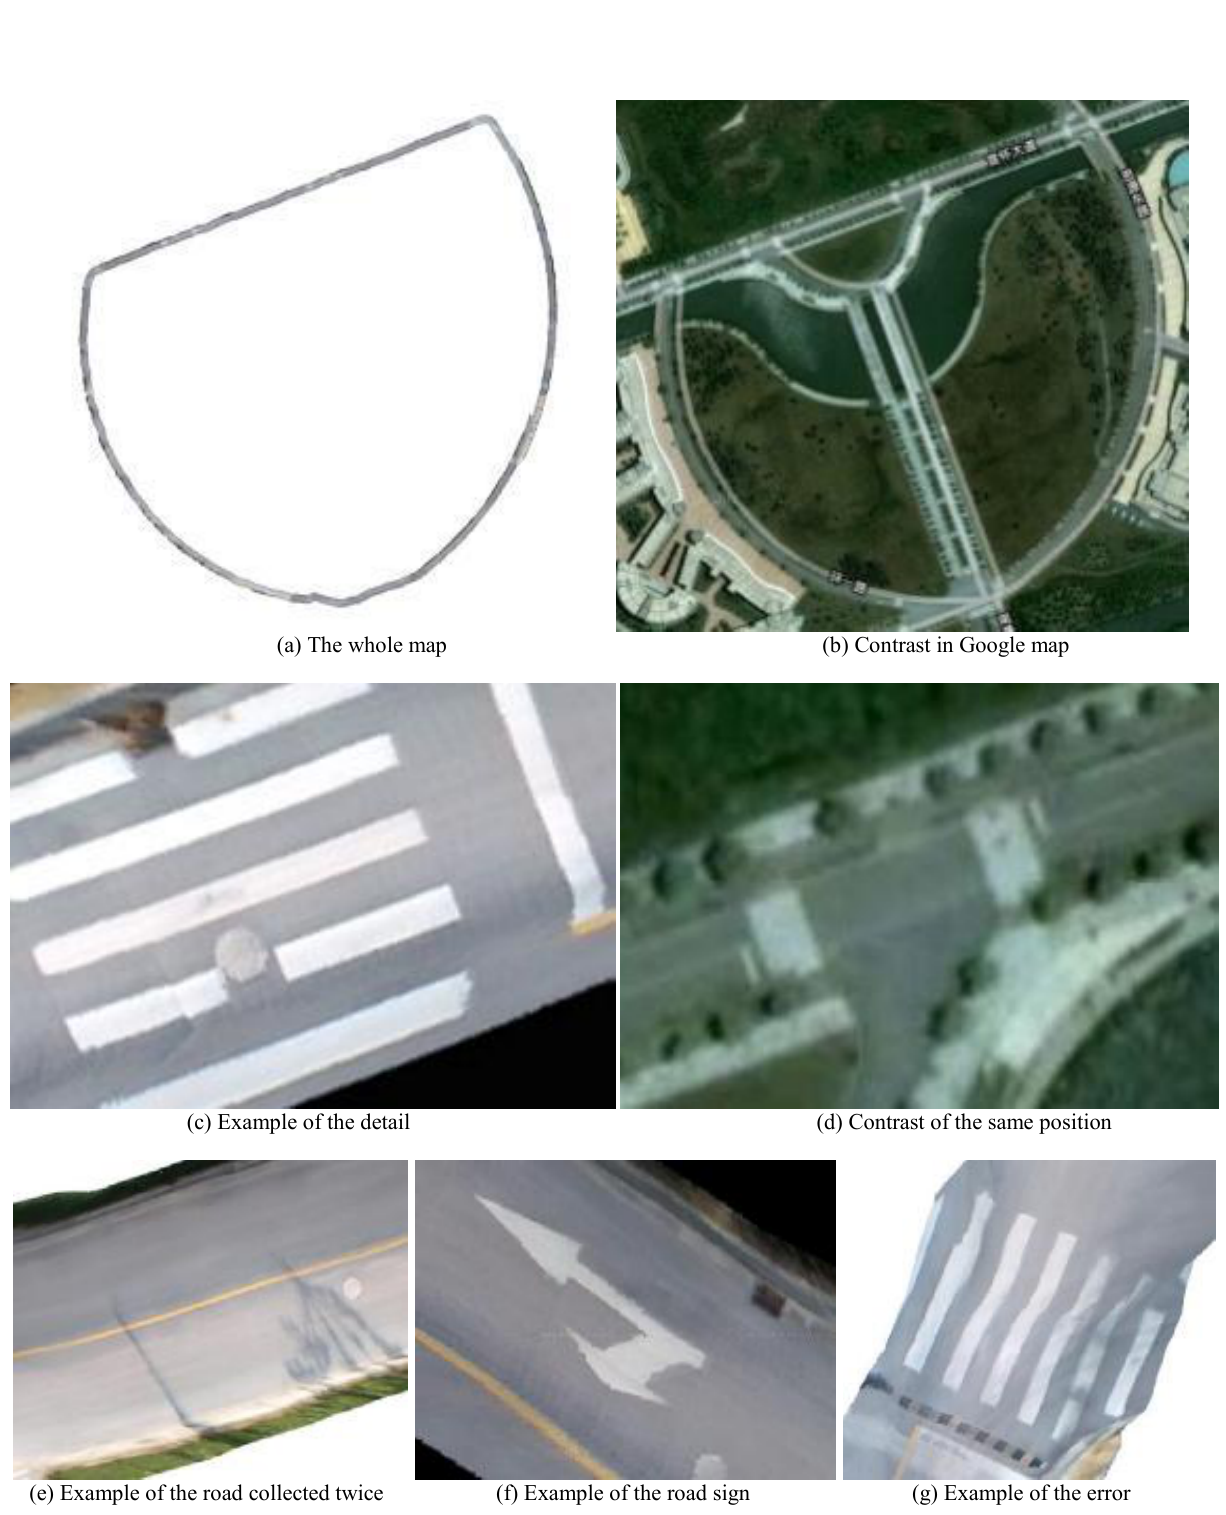
Fig.8. experiment result in